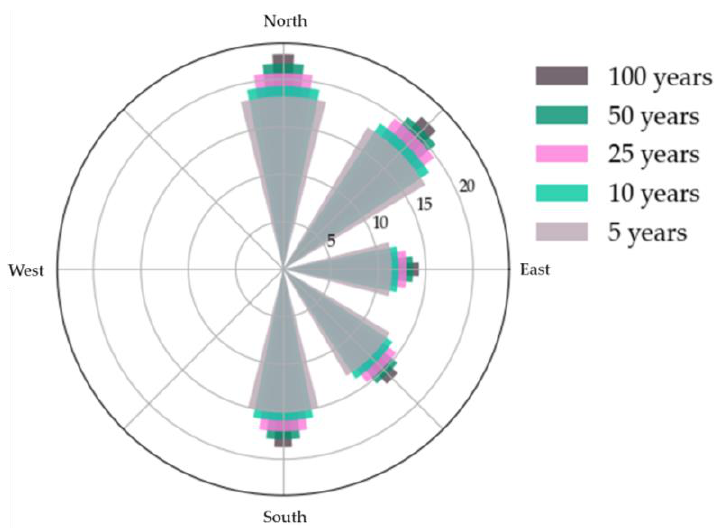
Figure 2. Monthly distribution of storm surges of different causes in the YRD from 2014 to 2021. The primary driver of storm surges is wind stress. By analyzing the wind direction of 42 storm events in Dongying City, it was found that the main wind directions are NE, N, and E, accounting for 52.38%, 23.81%, and 11.90%, respectively. According to the observation at Dongying Port Marine Station from 2011 to 2015 [18], the strong wind in Dongying Port mainly occurs in the NE, NW, N, W, and E directions. In the NE direction, the average extreme wind speed is 23.02 m/s, with a peak value of 27.90 m/s. The maximum wind speed in the N direction is 28.2 m/s with an average extreme wind speed of 24.24 m/s; the maximum wind speed in the E direction is 30.6 m/s, while the average extreme wind speed is 23.44 m/s. In the work of [7], Mesoscale Model 5 (MM5) was used to simulate the hourly wind field in the YRD, and Pears-III distribution was used to calculate the wind speed return period in five directions, as shown in Figure 3.